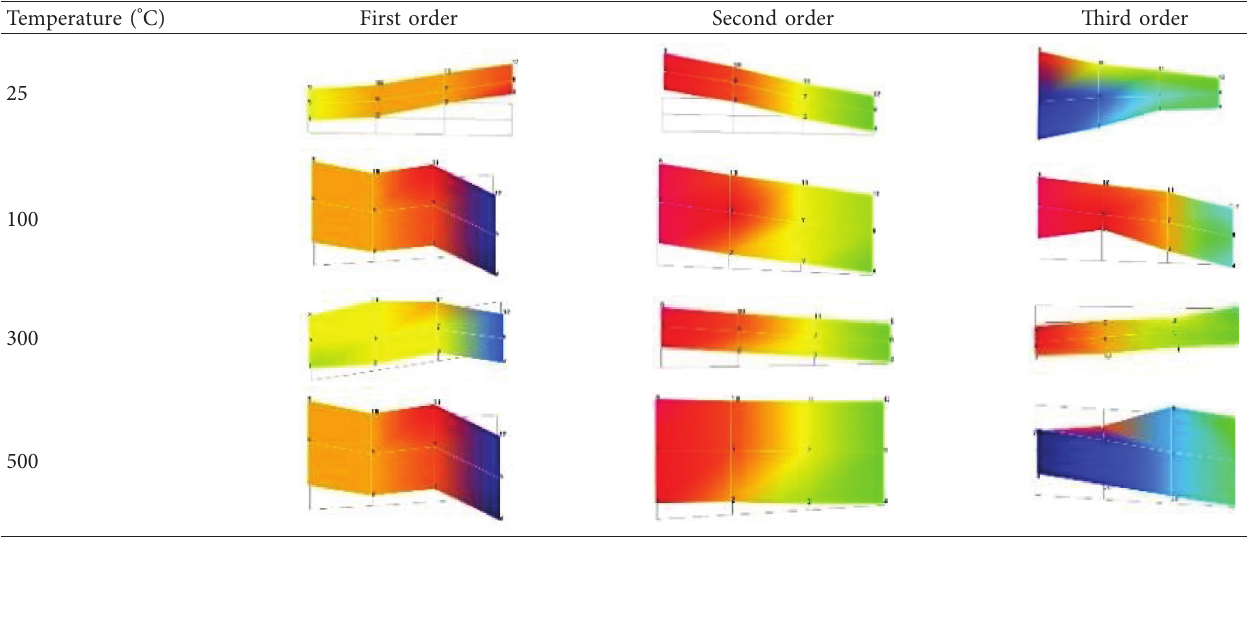
Figure 15: First three order modal frequencies of the cantilever structures under different ambient temperatures. (a) First order. (b) Second order. (c) Third order. Table 9: First three order modal shapes of the cantilever structure under different temperatures.